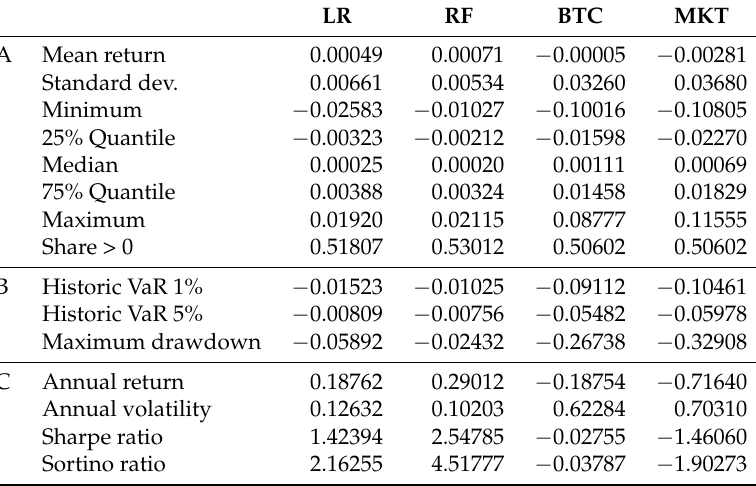
Table 2. Daily and annualized risk-return metrics for the logistic regression (LR) and the random forest model (RF) model when investing in the top-3 and flop-3 coins, versus Bitcoin (BTC) and the general market (MKT), i.e., an equal investment in all coins at the beginning of the trading period. Panel A depicts daily return characteristics, panel B depicts risk and panel C annualized risk-return metrics. LR RF BTC MKT A Mean return 0.00049 0.00071 − 0.00005 − 0.00281 Standard dev. 0.00661 0.00534 0.03260 Minimum − 0.02583 −